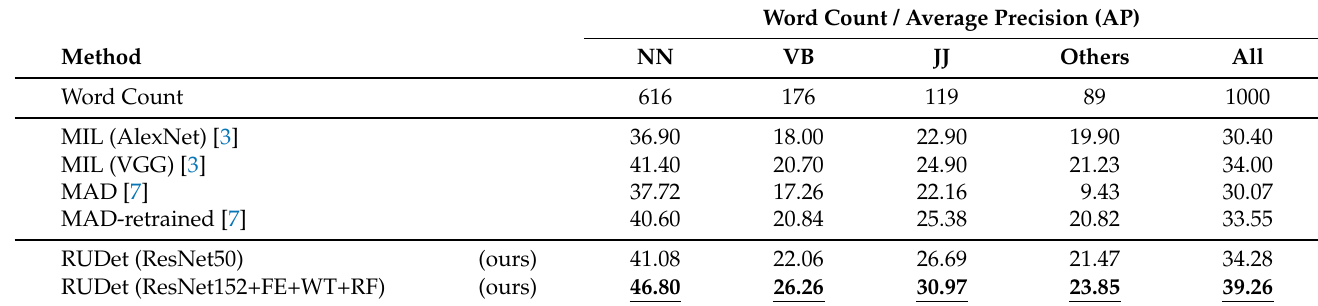
Table 2. The comparison of the proposed RUDet with other methods. For the proposed RUDet, “ResNet152” means using Residual Network with 152 layers (ResNet152) as backbone, and “+FE+WT+RF” means using the FE module, the WT module, and the RF module. In each column, the highest values are marked by underline